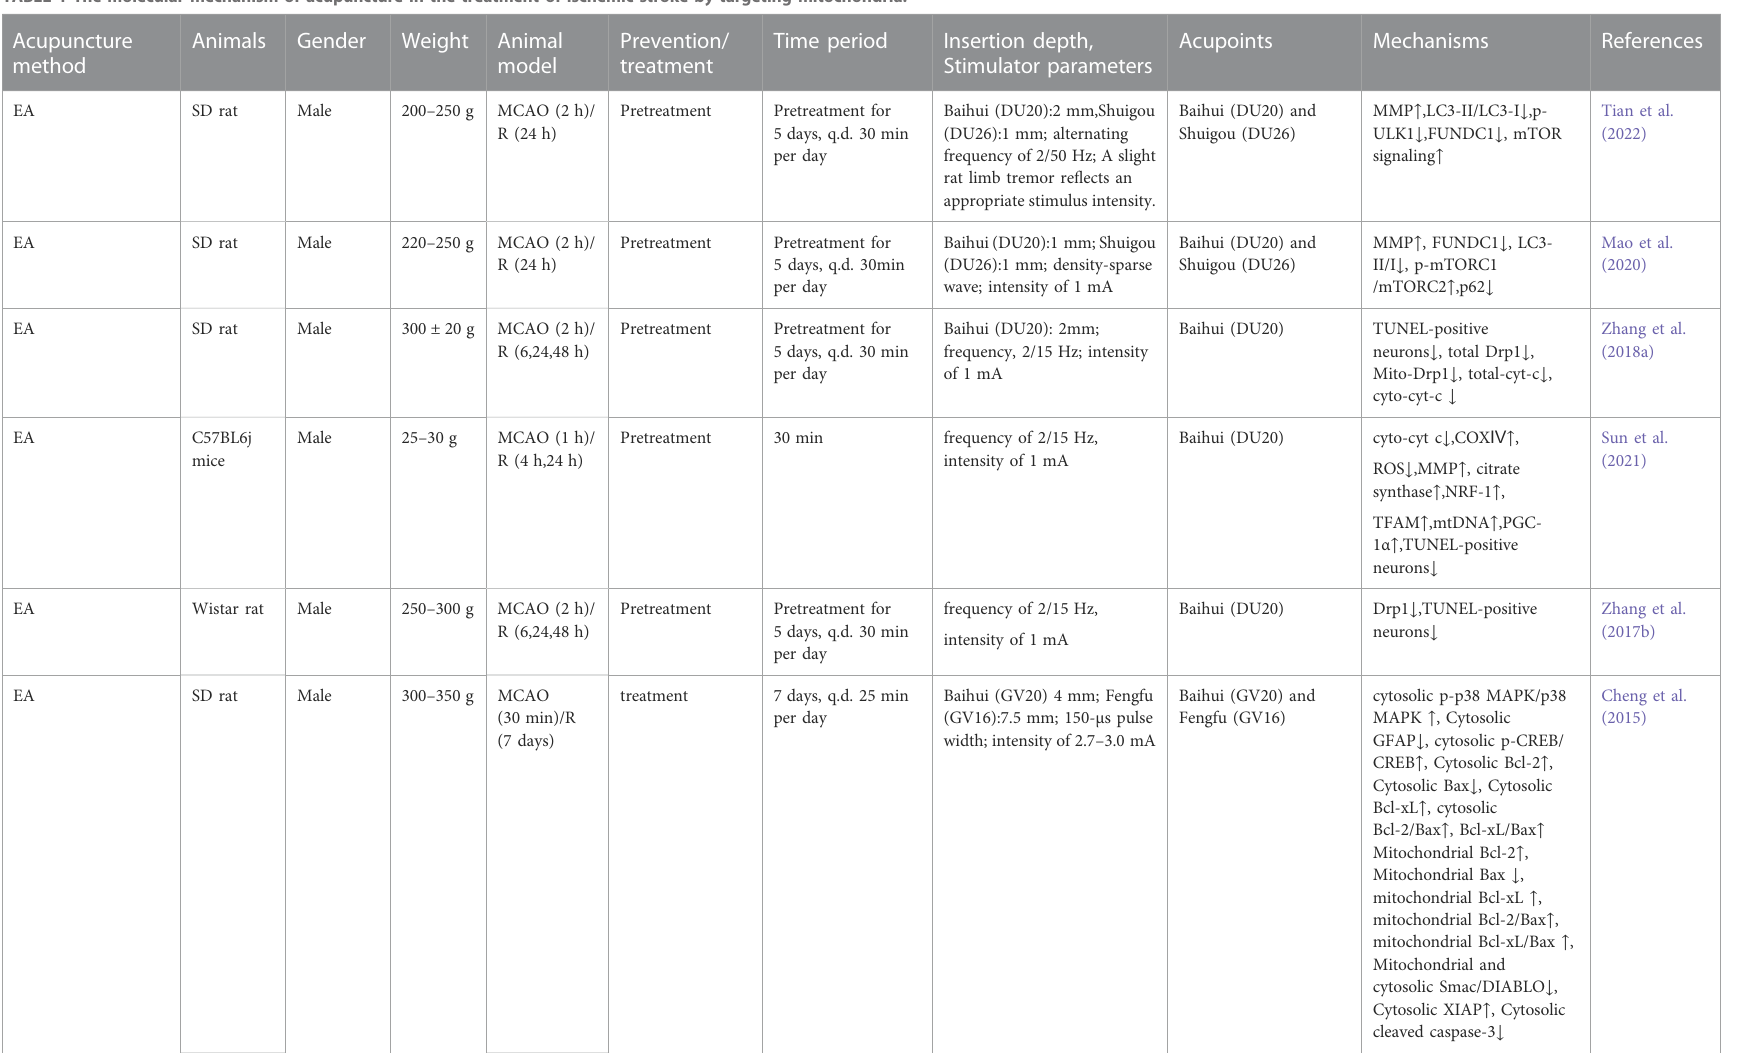
TABLE 1 The molecular mechanism of acupuncture in the treatment of ischemic stroke by targeting